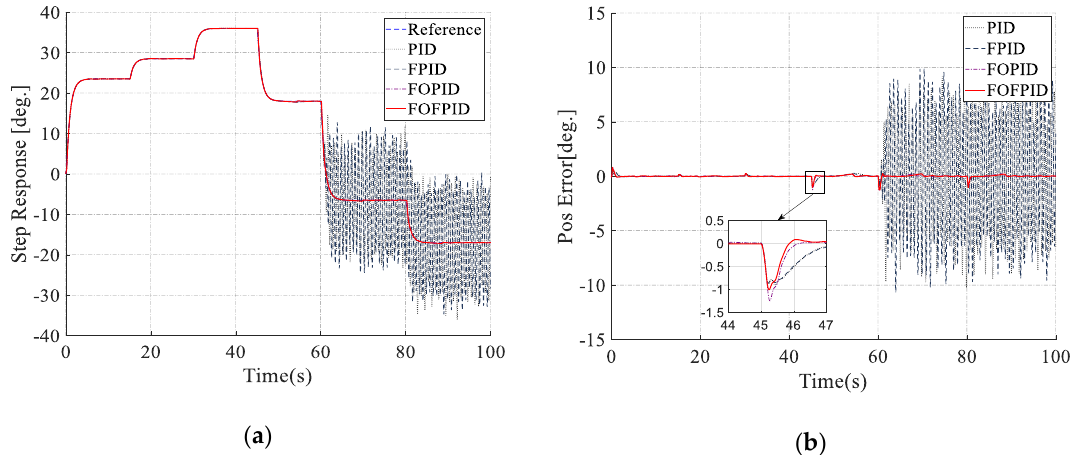
Figure 18. Comparison for multi-step trajectory (cutoff frequency 9 Hz and the payload is 150 N). ( a ) Output performance; ( b ) error effort.